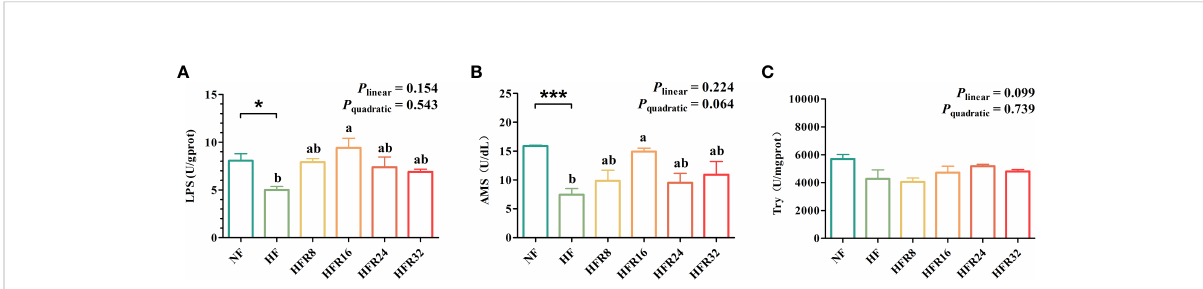
FIGURE 2 Effects of resveratrol supplementation on the hepatic digestive enzyme activities in common carp ( Cyprinus carpio ). (A) lipase (LPS) content; (B) amylase (AMS) content; (C) trypsin (Try) content. Data are presented as means ± SEM. “ * ” represented statistical difference between the NF group and the HF group using student ’ s t-test (* P < 0.05 or *** P < 0.001). “ ab ” represented statistical difference among different RSV levels in the HF diet. P -values indicated a linear and quadratic to dietary RSV levels using orthogonal polynomial analysis. Bars with different superscripts are statistically different ( P < 0.05, n = 3).